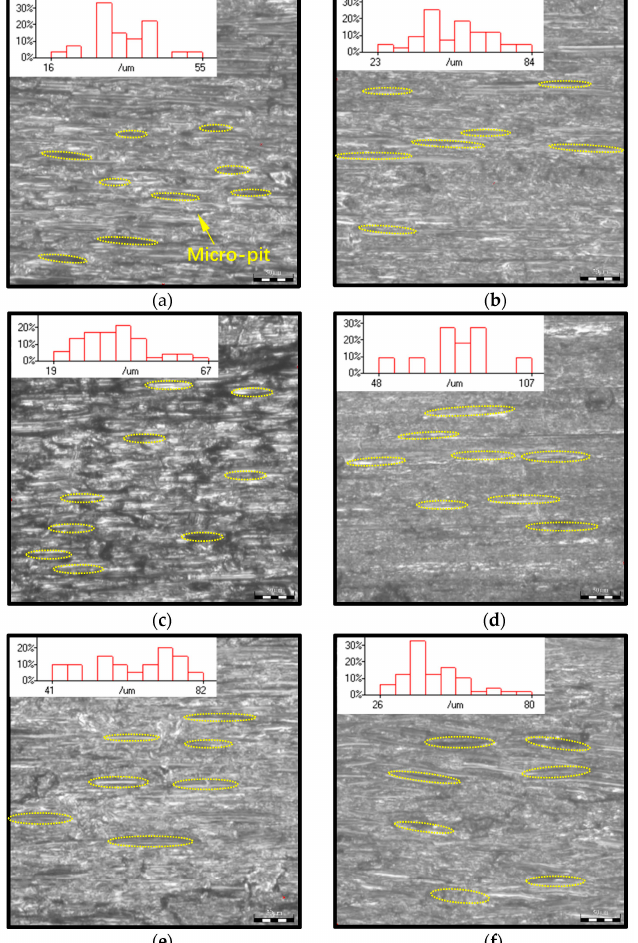
Figure 10. Experimental micro-pit comparisons: ( a ) 𝑛 = 2000 RPM , 𝑉 (cid:3046) = 10 μm/s , ( b ) 𝑛 = 2000 RPM , 𝑉 (cid:3046) = 20 μm/s , ( c ) 𝑛 = 2000 RPM , 𝑉 (cid:3046) = 30 μm/s , ( d ) 𝑛 = 3000 RPM , 𝑉 (cid:3046) = 10 μm/s , ( e ) 𝑛 = 3000 RPM , 𝑉 (cid:3046) = 20 μm/s , and ( f ) 𝑛 = 2000 RPM , 𝑉 (cid:3046) = 10 μm/s , convex.